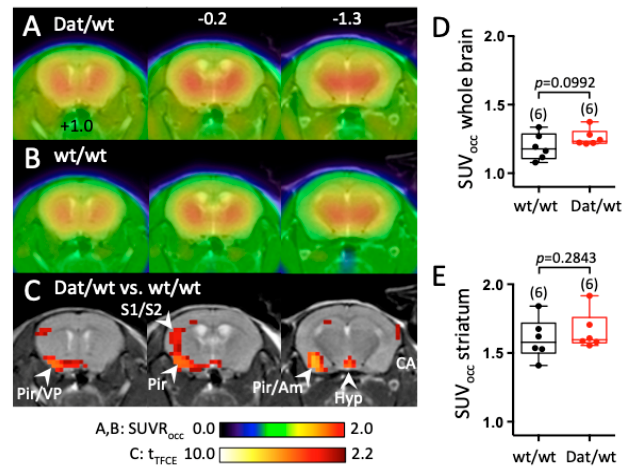
Figure 4. Change in 6-[ 18 F]FMT uptake in the brain of Dnmt3a2 / 3L Dat / wt mice compared to control littermates. ( A ) Mean cerebral 6-[ 18 F]FMT uptake in Dnmt3a2 / 3L Dat / wt mice ( n = 6). Image intensity was normalized to 6-[ 18 F]FMT uptake in the occipital cortex. ( B ) Mean 6-[ 18 F]FMT uptake of control littermates ( n = 6). Both genders were used, and uptake took place under anaesthesia. ( C ) Student’s t -test ( p < 0.05, controlled for multiple testing with a TFCE procedure) for comparison between control littermates and Dnmt3a2 / 3L Dat / wt mice. Red voxels indicate significantly higher 6-[ 18 F]FMT uptake in Dnmt3a2 / 3L Dat / wt mice. Significantly higher uptake in control mice was not observed. ( D ) Comparison of global 6-[ 18 F]FMT uptake between groups. ( E ) Comparison of striatal 6-[ 18 F]FMT uptake between groups. Abbreviations: Am: amygdala, Hyp: hypothalamus, Pir: piriform cortex, S1 / S2: primary and secondary sensory cortex, VP: ventral